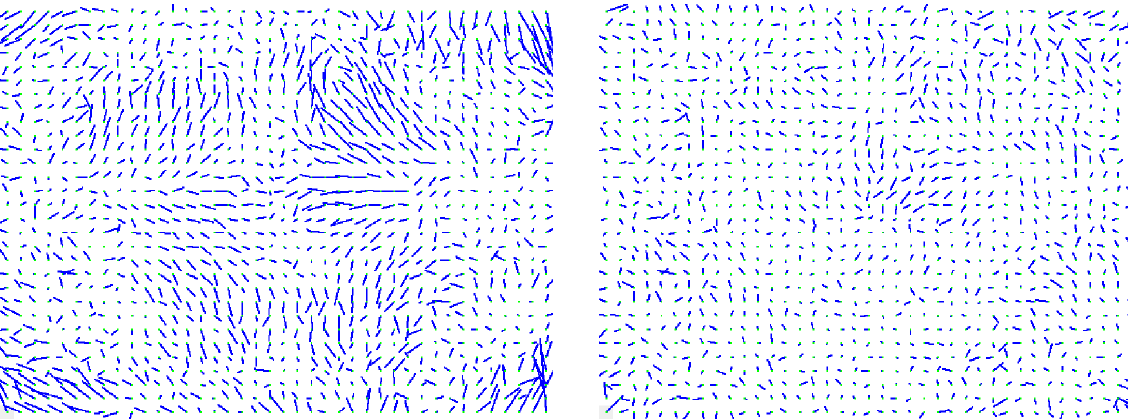
Figure 8: Direction and magnitude of the average reprojection error of all automatic tie points for the Phantom 2 Vision+ dataset flown at 8m / s . Results are shown both for the standard fisheye camera model (left) and the linear rolling shutter model (right). The length of the error vectors is magnified for better